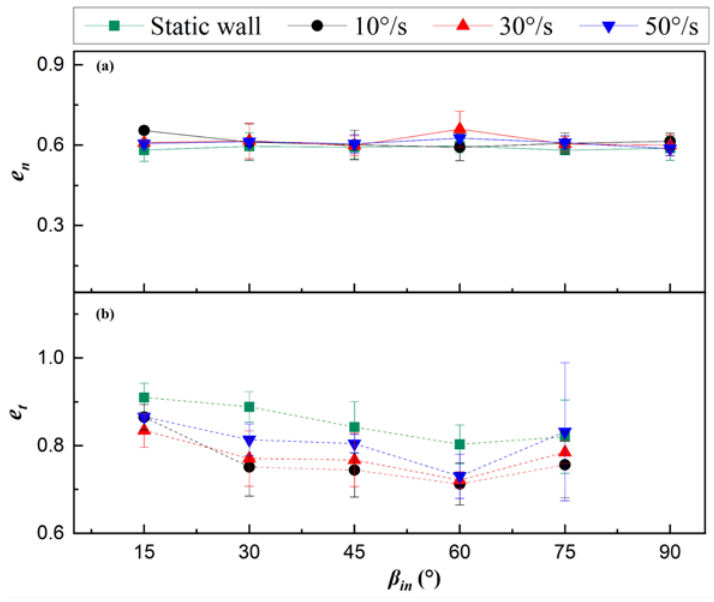
Figure 6. Velocity coefficient of restitution of particles at different rotational speeds: ( a ) Normal velocity coefficient of restitution; ( b ) Tangential velocity coefficient of restitution.